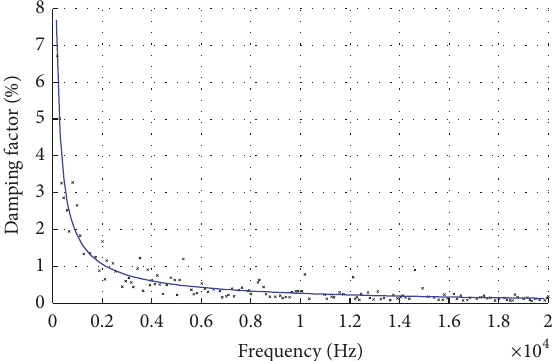
Figure 16: The damping factor values distribution versus natural